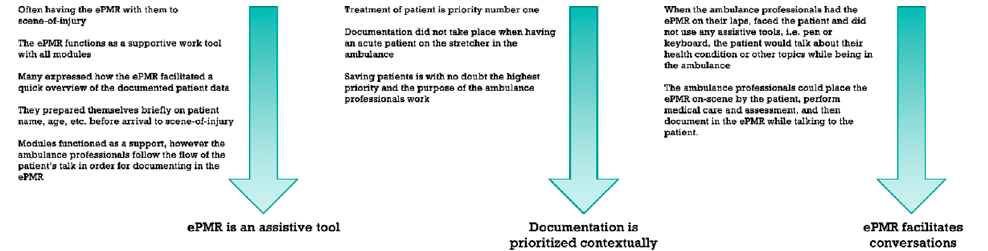
Figure 2. Categorizations of themes into main patterns.